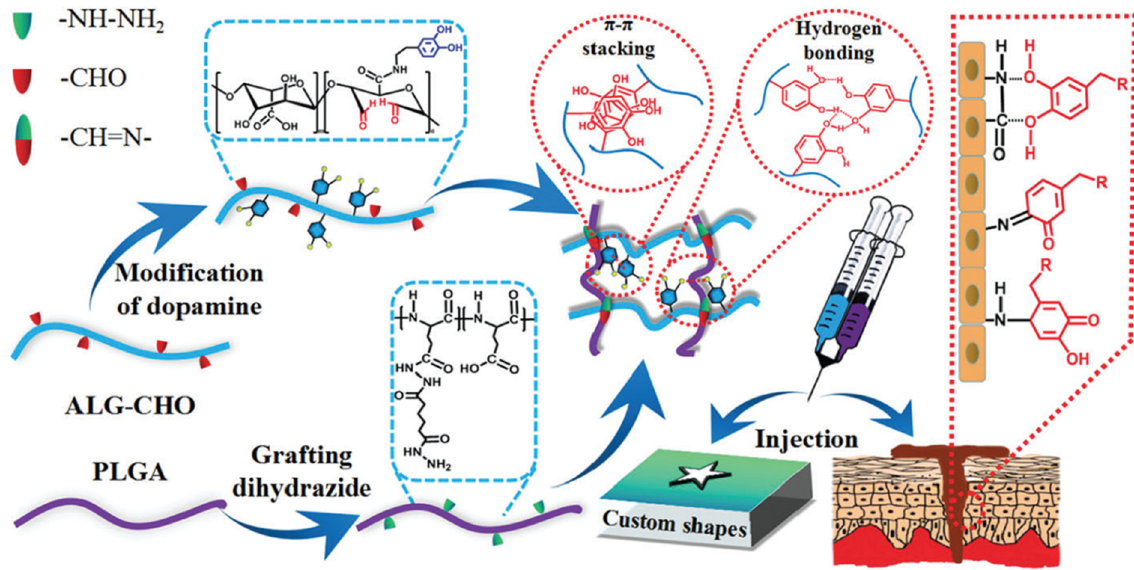
Figure 14. Schematic representation of the development of mussel-inspired PLGA/ALG–CHO–Catechol adhesive injectable self-healing hydrogels. (Reproduced with permission from Ref. [205]. Copyright 2018, The Royal Society of Chemistry).